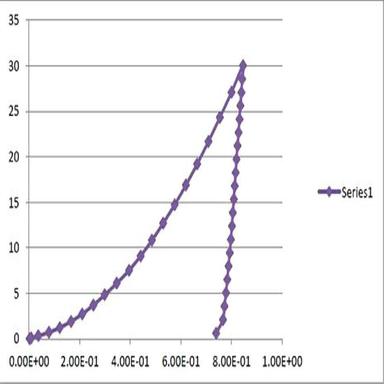
Graph between indentation depths vs hardness for 1.5%.